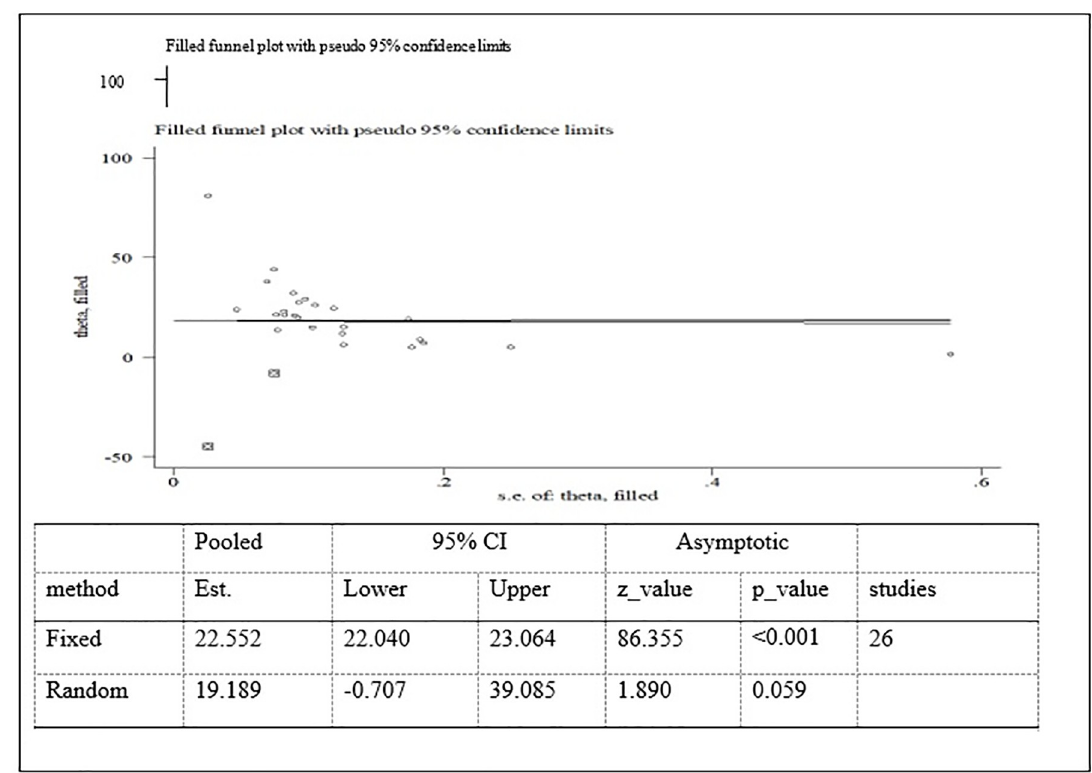
Fig 12. Trim and fill analysis for thinness among adolescent in